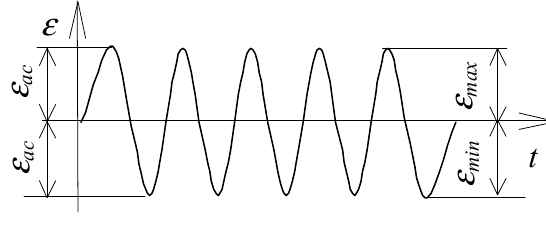
Figure 2. Load scheme.